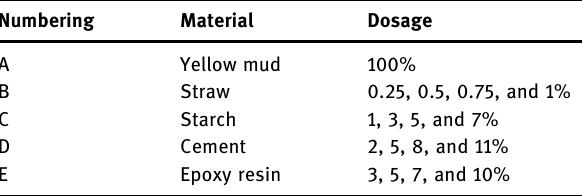
Figure 8: Quadruple constant strain direct shear apparatus.